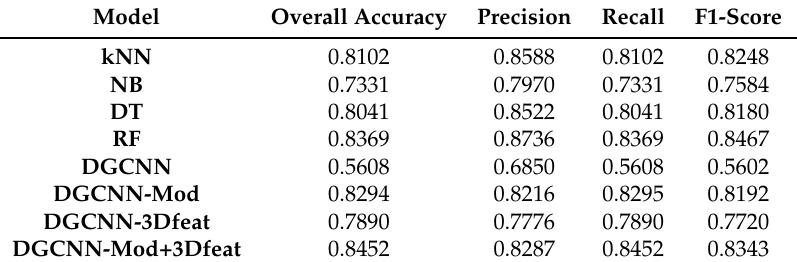
Table 3. Weighted metrics computed for the Test set of the SMV scene.